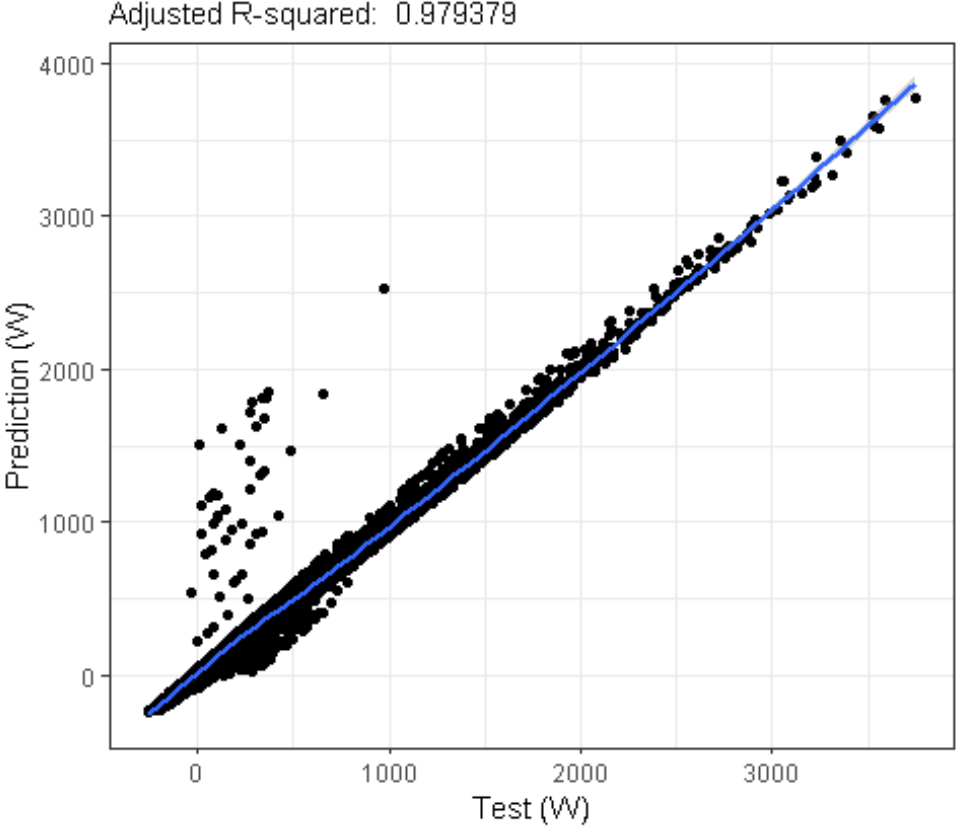
Figure 6. Comparison of the prediction and the test results for a selected model of all seasons.